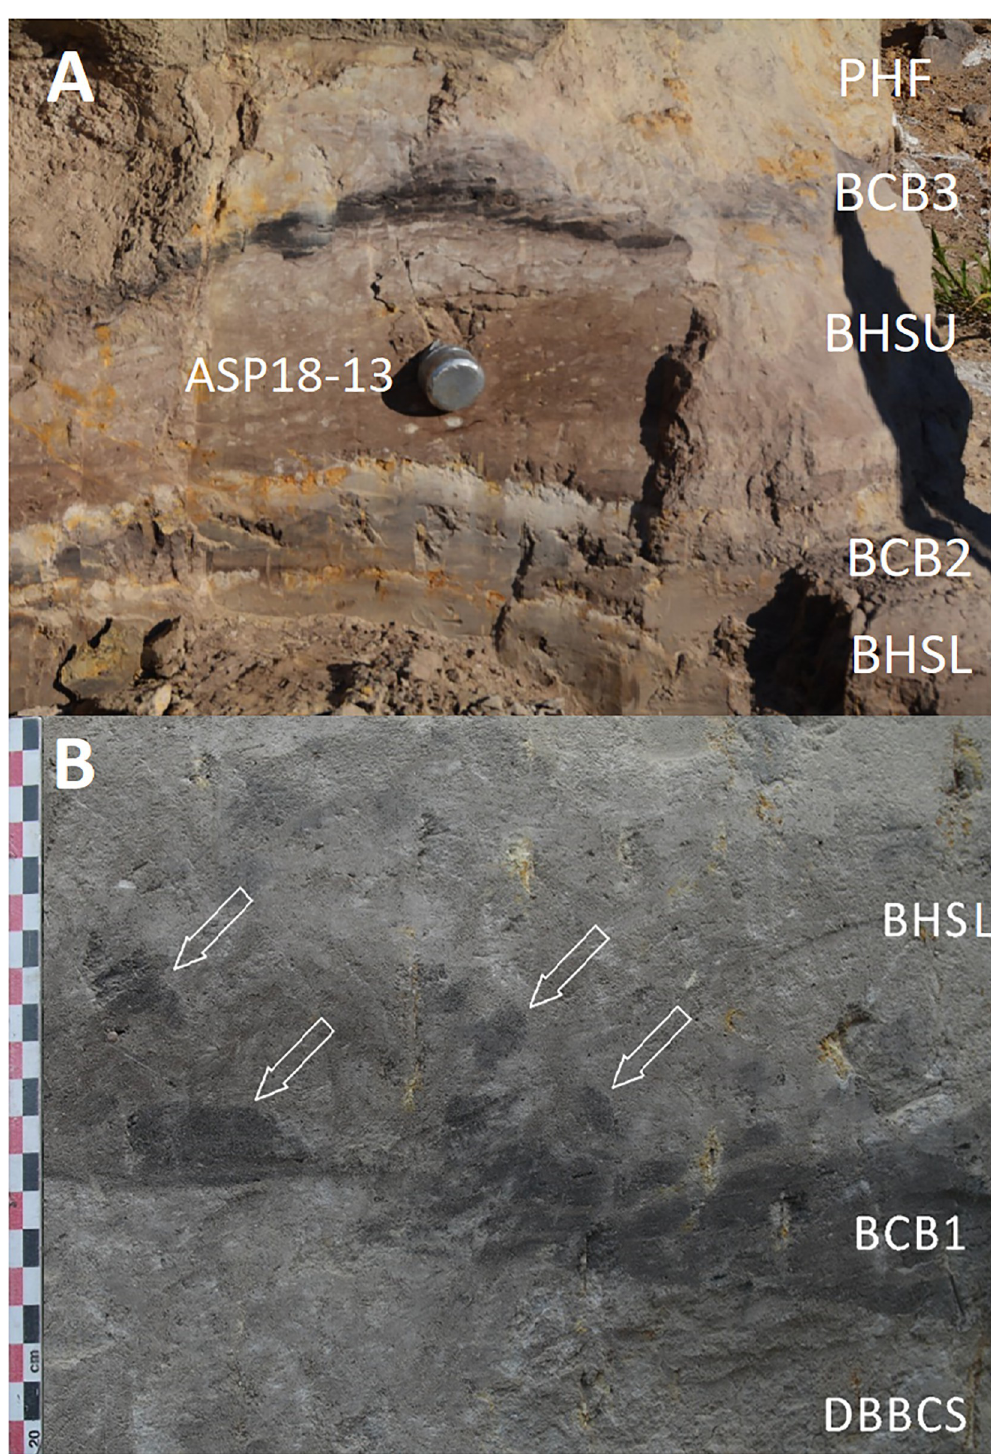
Fig 4. A. Location of luminescence dating sample ASP18-13 in the BHSU of Cutting 1 Extension B. Close-up of the boundaries between DBBCS, (BCB), and BH). BCB1 tapers leftwards and its top is evidently shaped by an erosion feature. Reworked clods of BCB1 (arrows) are embedded in